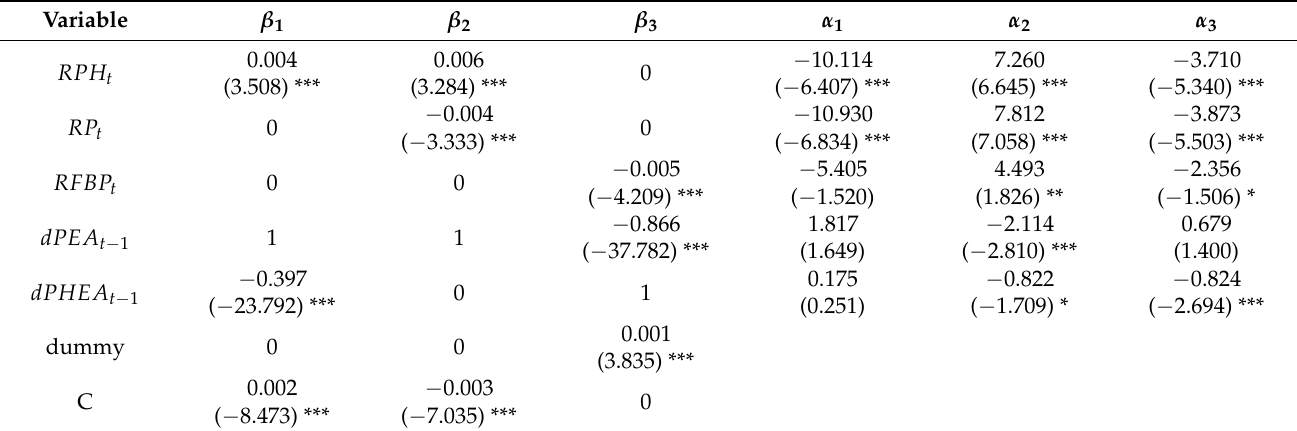
Table 3. A structural representation of the cointegrating